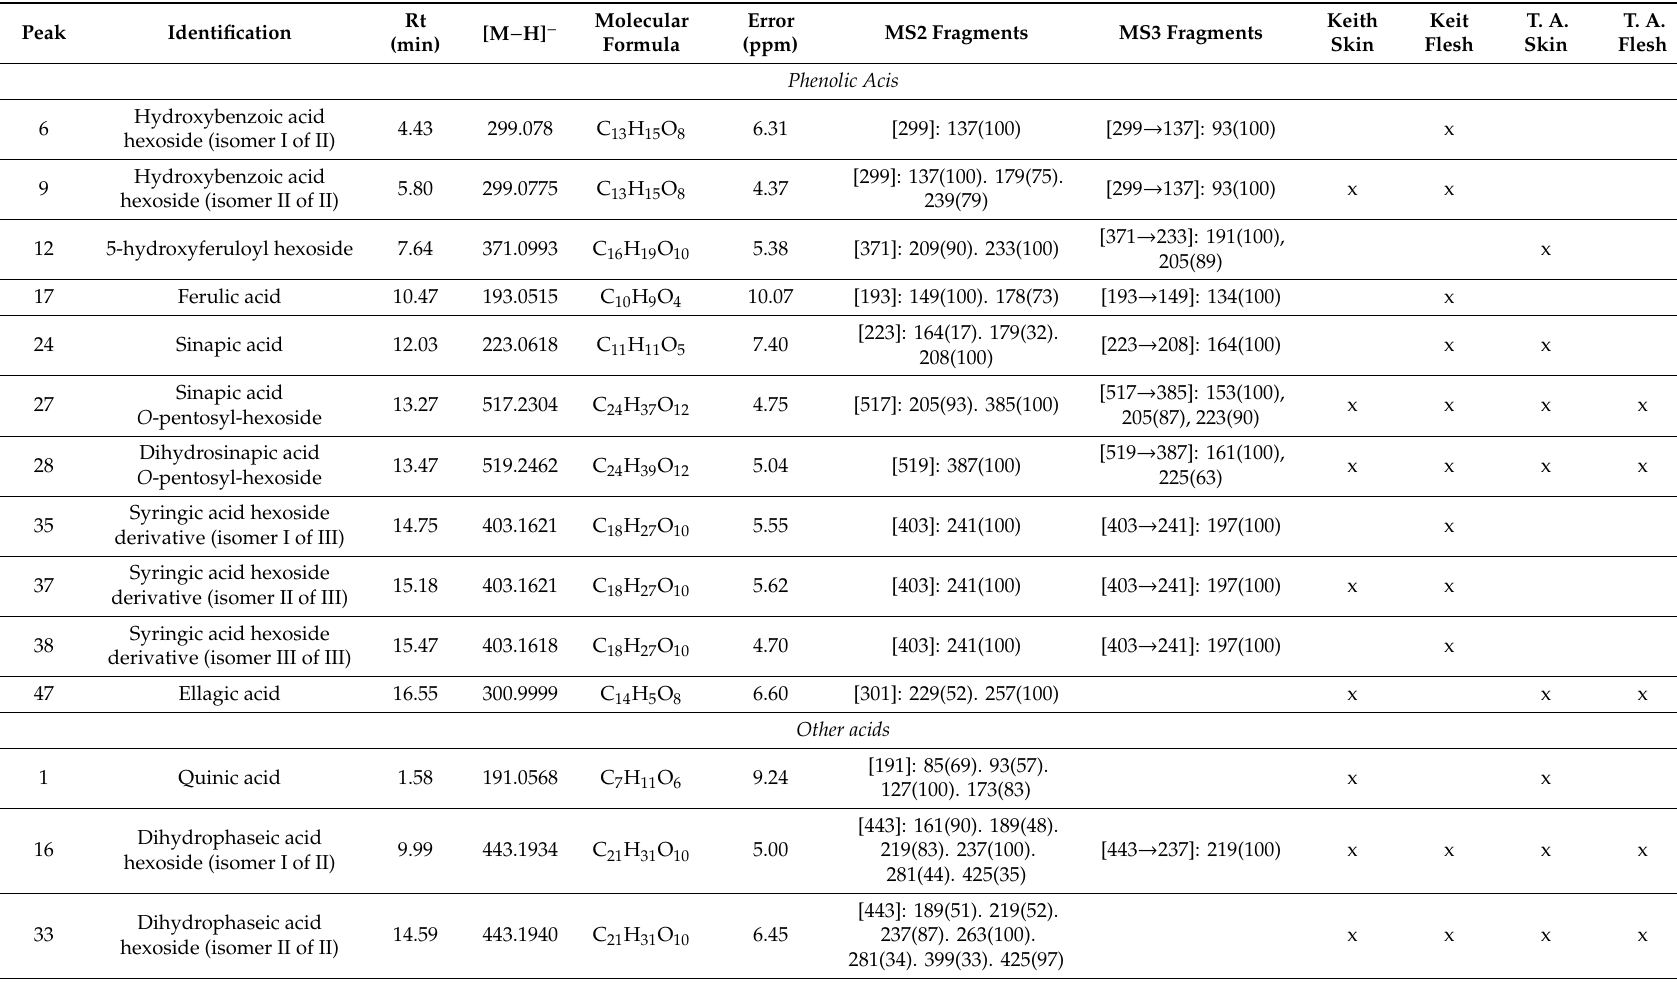
Table 2. Profile of phenolic compounds identified by UPLC-DAD-ESI-TQ-MS analysis for mangoes Keitt and T. Atkins